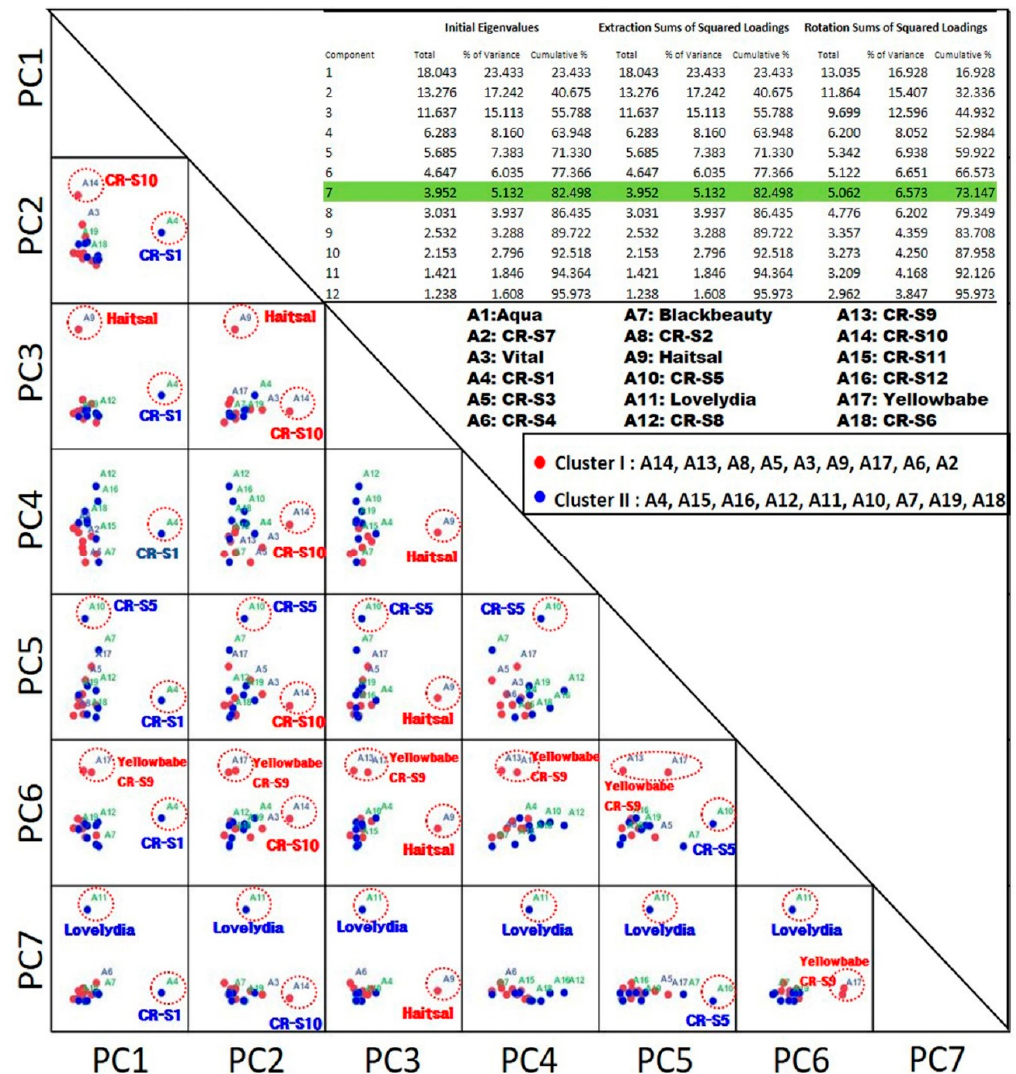
Figure 5. Principal component analysis (PCA) score plot of volatile compounds of 12 rose mutants and their original cultivars.